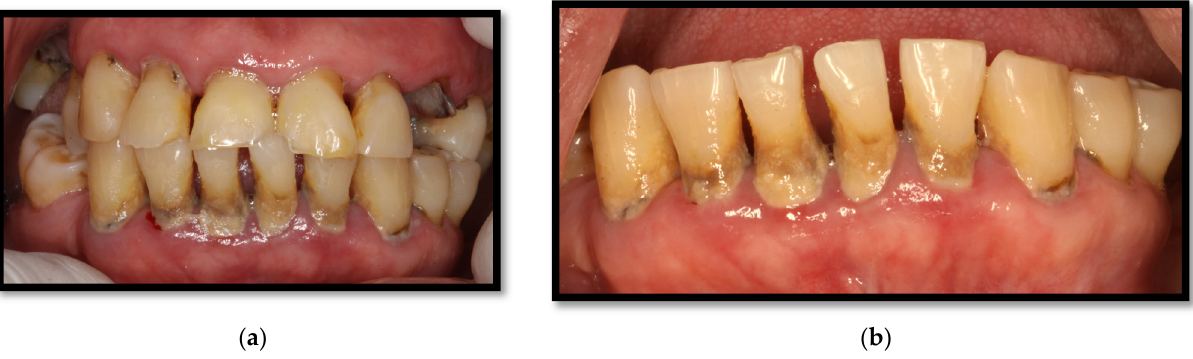
Figure 5. ( a ) Upper and lower arch chronic periodontitis ( b ) Anteroinferior sextant chronic perio- dontitis.